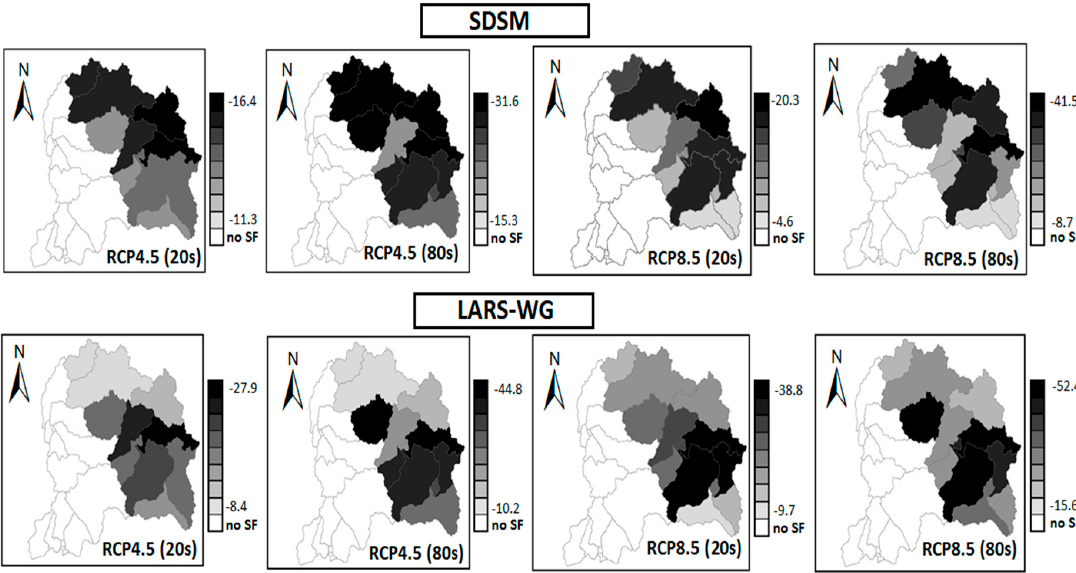
Figure 13. Spatial distribution of relative changes in snowmelt during the 2020s and 2080s over the JRB (Jhelum River Basin) under RCP4.5 and RCP8.5 using climatic data outputs of SDSM and LARS-WG; no SF —represents no snowfall.